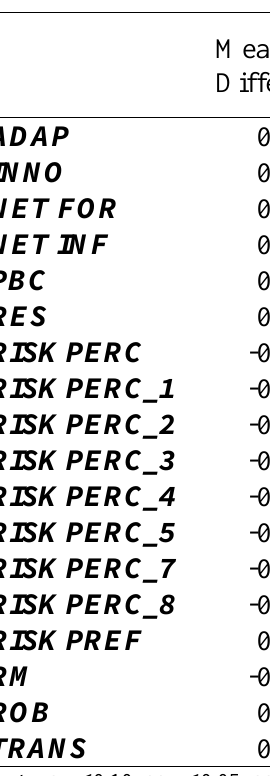
Table A1.9. Equal means and variance